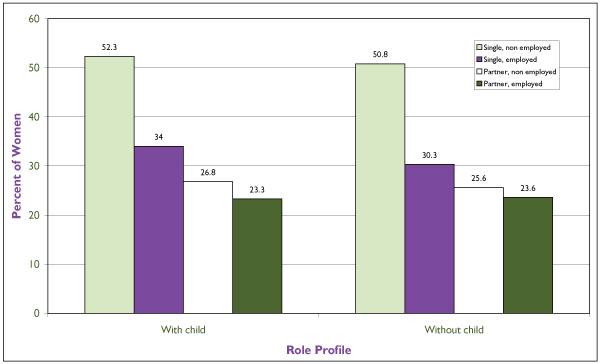
Percent reporting high psychological